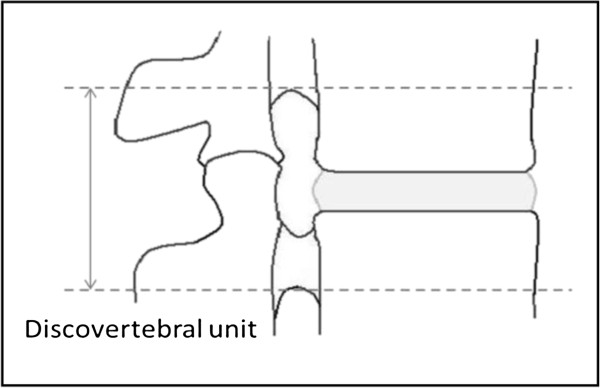
Discovertebral unit modified from [6].